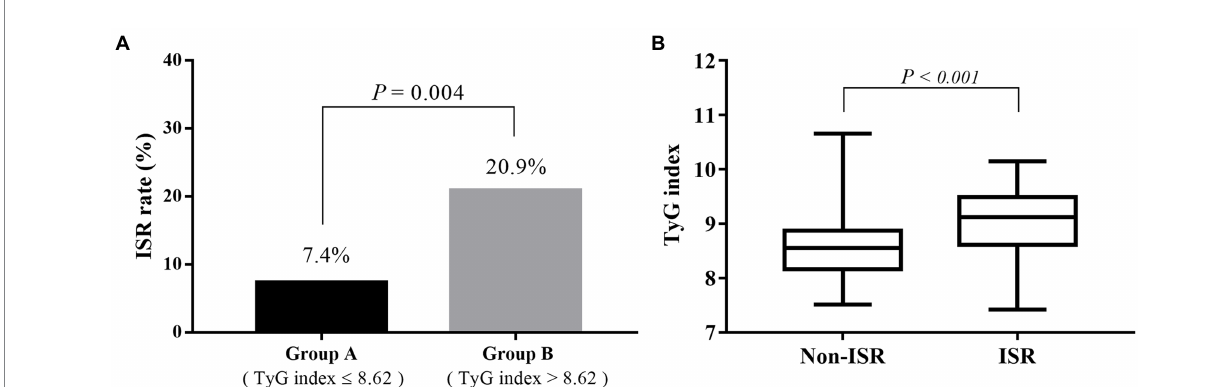
FIGURE 3 The relevance of the preoperative TyG index on the risk of restenosis. (A) The restenosis rate of participants in group B was significantly higher than that in group A (20.9 vs. 7.4%, p = 0.004). (B) The TyG index was significantly higher in the restenosis group than in the non-restenosis group (8.55 ± 0.53